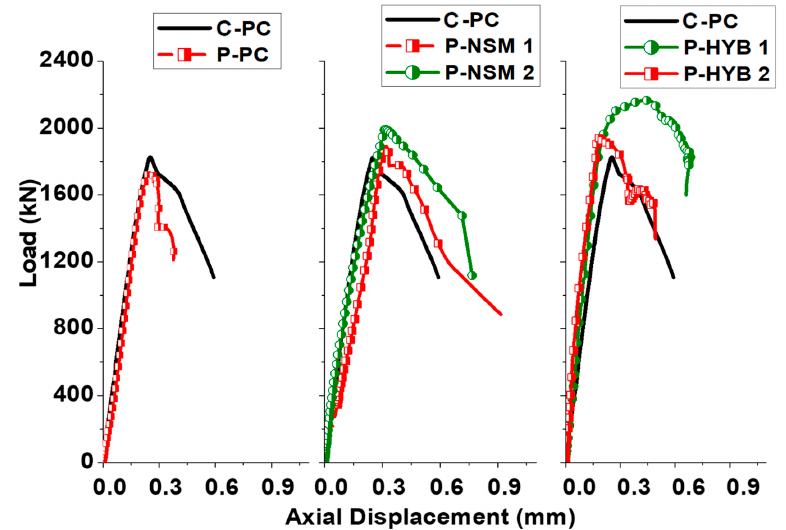
Figure 5. Overall load-displacement behaviour of pre-damaged PC columns.